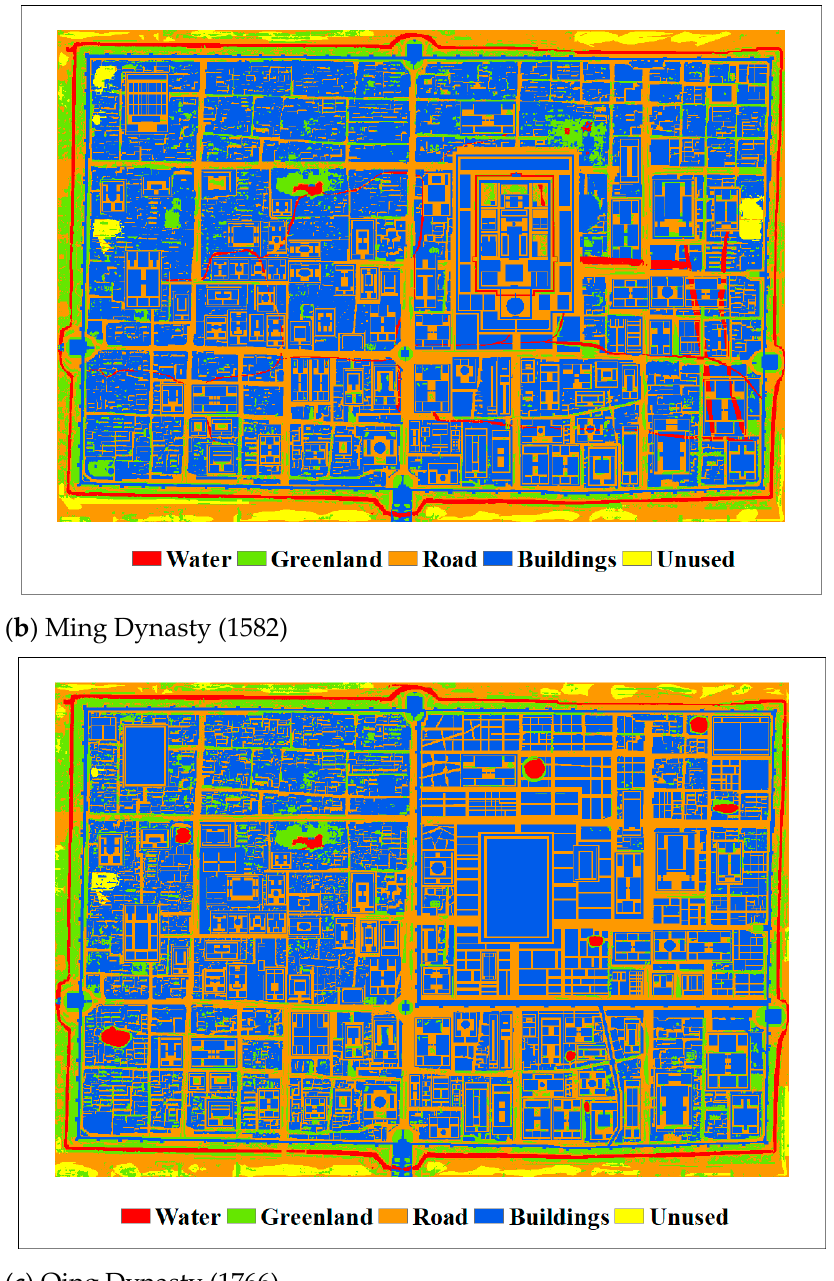
Figure 5. Land use in the three periods of the